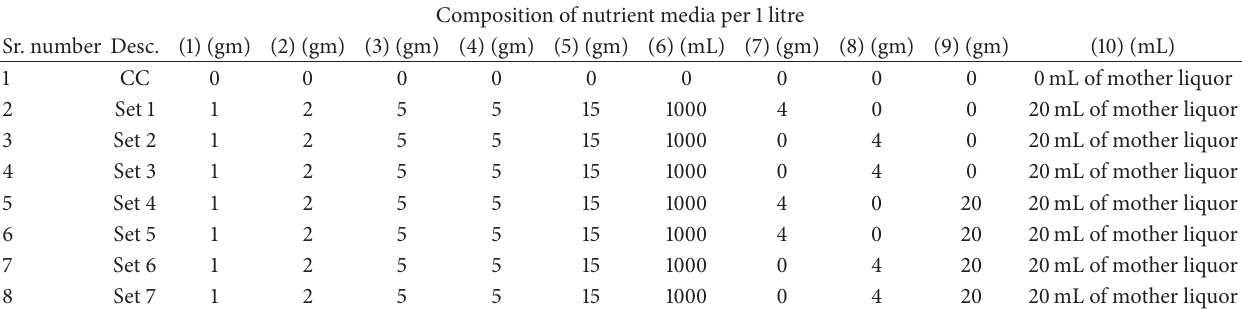
Table 2: Composition of nutrient media.